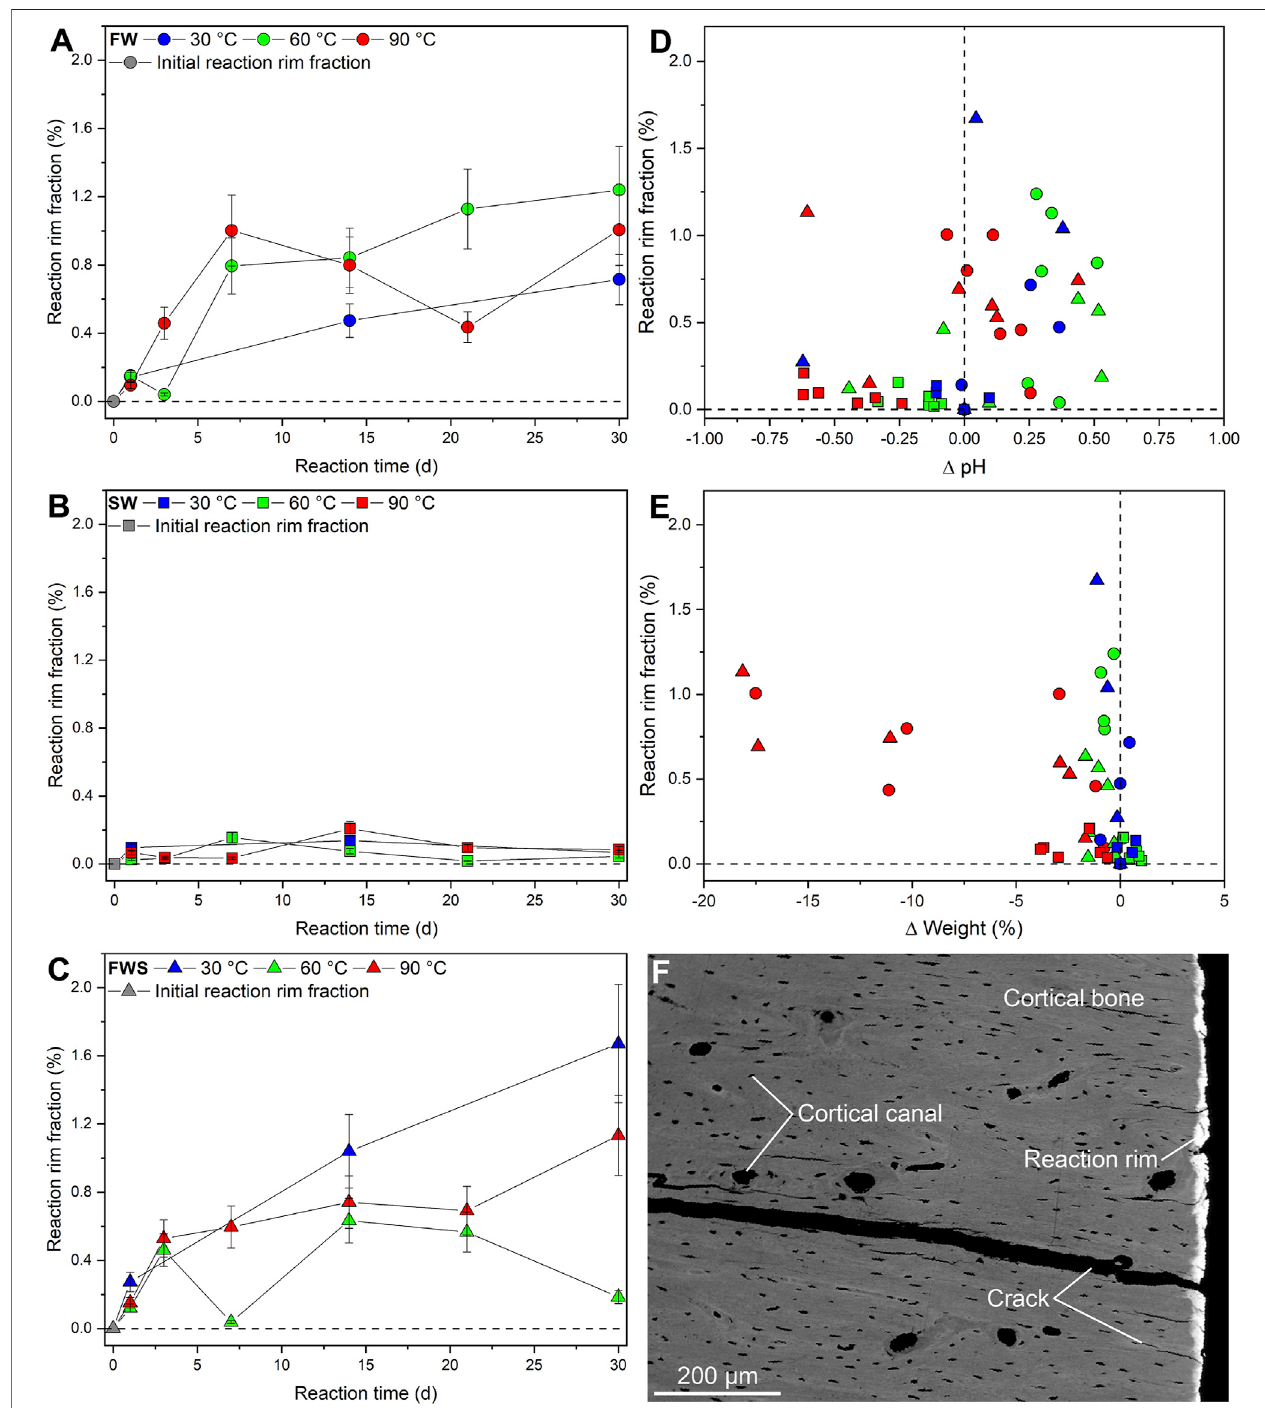
FIGURE 9 | Changes in the reaction rim observed during the experiments. (A-C) Development of the reaction rim fraction as percentage of the bone volume over time. (D,E) ReactionrimfractionplottedagainstchangesinpHandweight.Errorbarsofthereactionrimfractionrepresenttheestimated2-sigmastandarddeviation(see Table 5 ). The weight loss errors are smaller than the symbols. (F) Backscattered electron micrograph of a representative sample altered in the FW solution. Note the presence of the reaction rim and the absence of notable changes to the overall microarchitecture of the cortical bone.